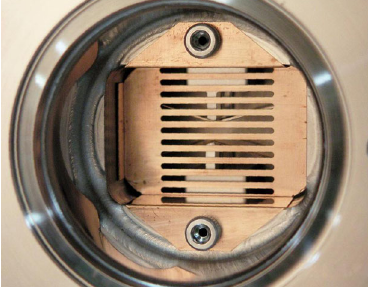
FIG. 10. Photograph of the screen shield for a viewport.